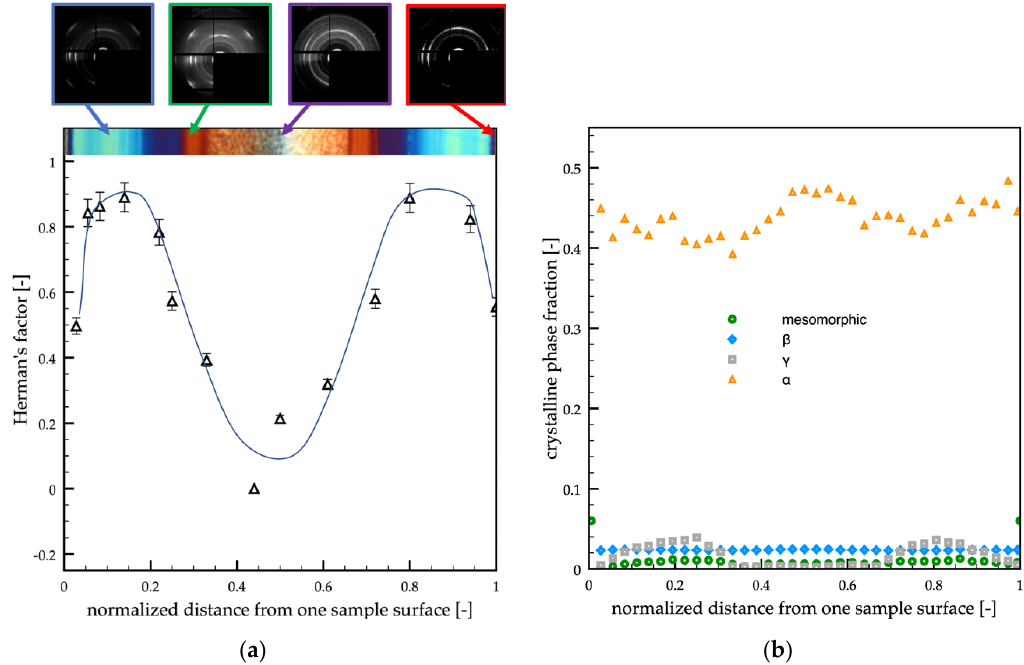
Figure 4. ( a ) WAXS analyses of the passive molding in different positions along the sample thickness. Each analyzed position is indicated on the optical micrograph. The distribution of the orientation in terms of Herman’s factor was also reported. ( b ) Distributions of mesomorphic, α, β, and γ-phase fractions along the sample thickness evaluated from the WAXS analyses. Polymers 2020 , 12 , x FOR PEER REVIEW